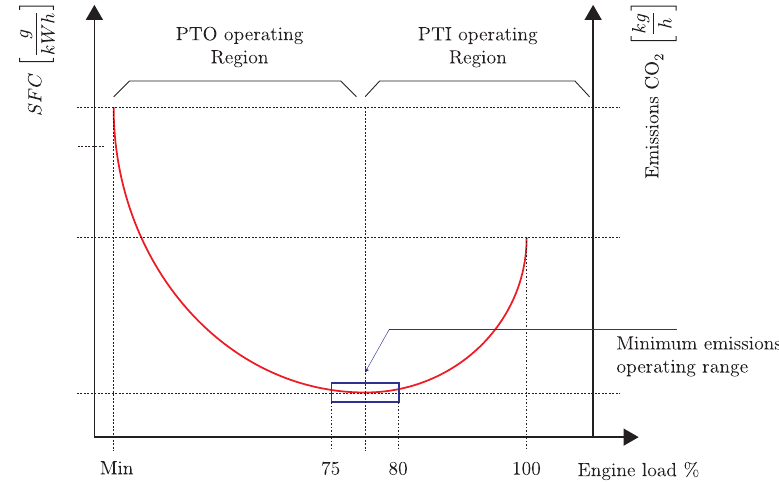
Figure 1. Power Take Off (PTO)/Power Take In (PTI) operating